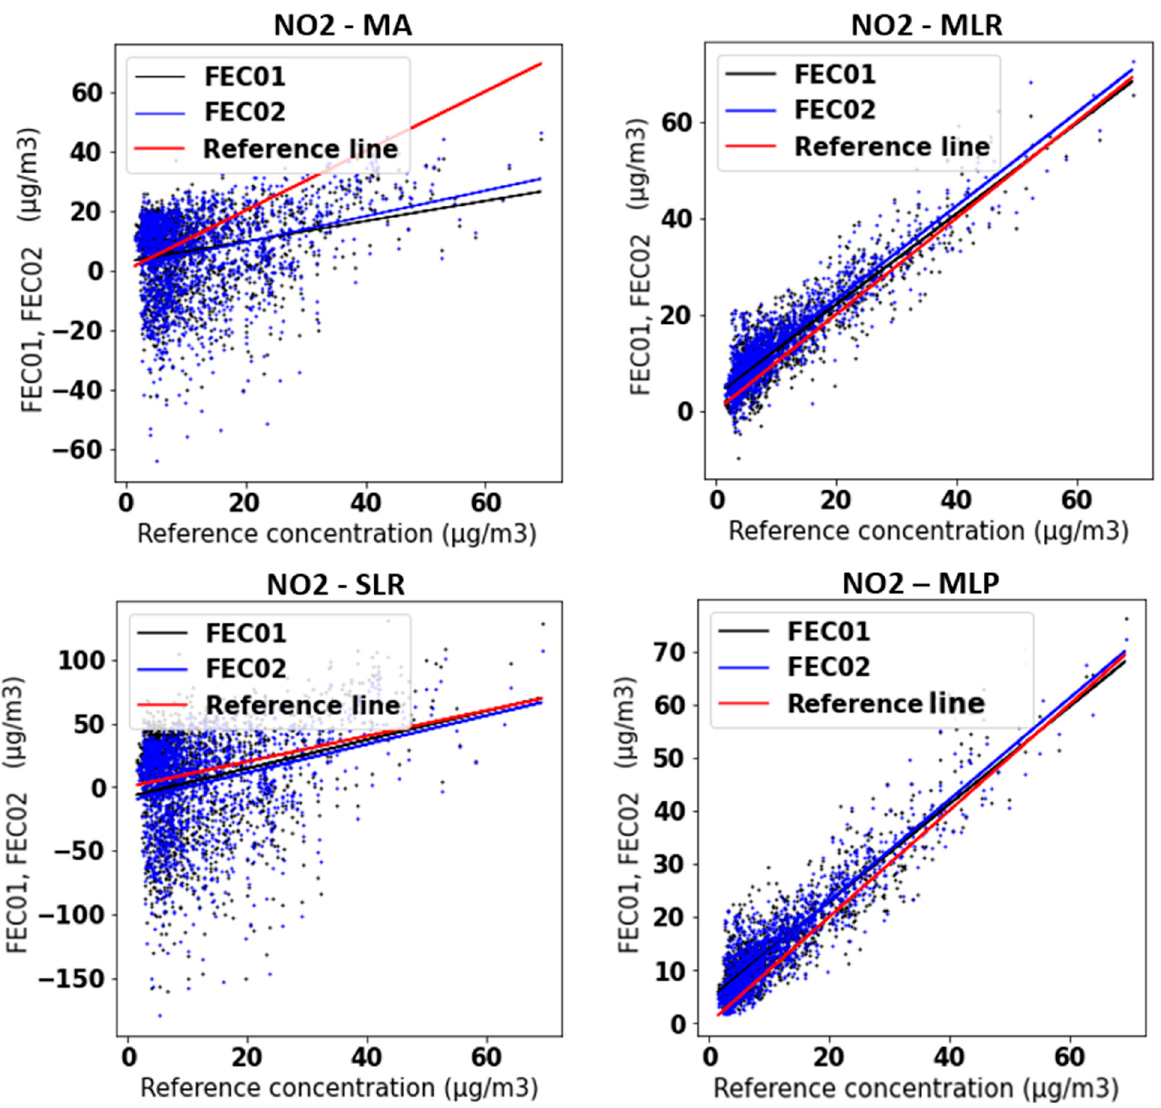
Figure 7. FEC01 and FEC02 concentrations obtained with MA, SLR, MLR and MLP vs. reference concentration.